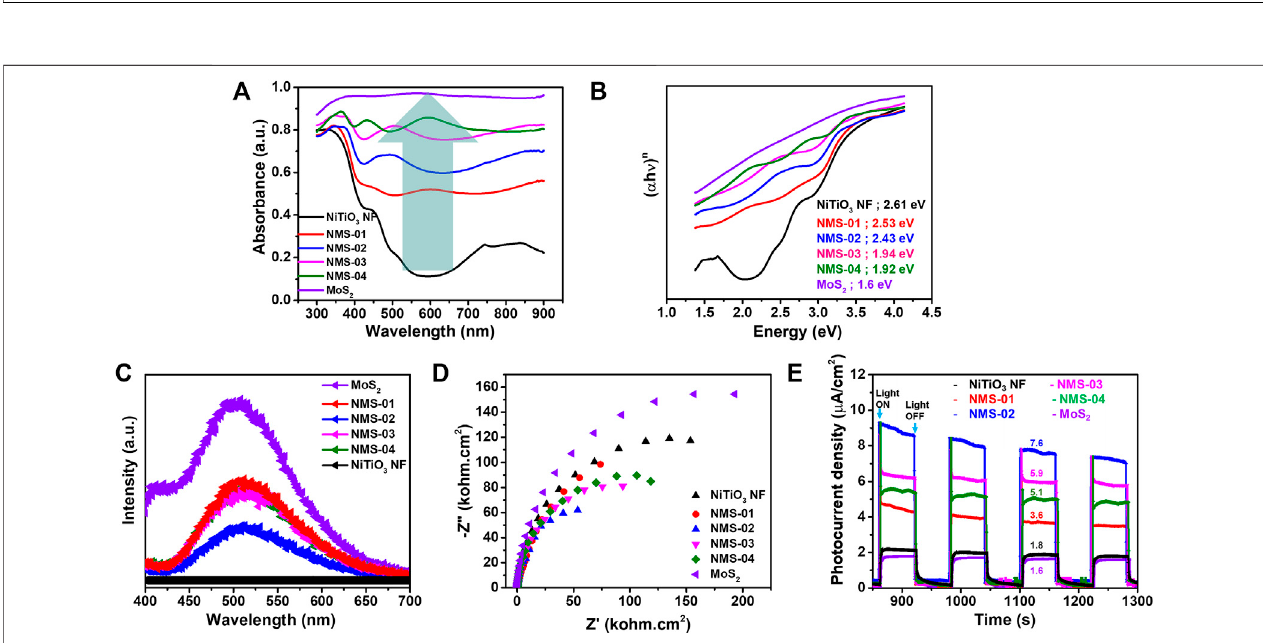
FIGURE5 |(A) Ultraviolet-visible lightabsorption (B) bandgap energy, (C) photoluminescence, and (D) electrochemicalimpedance spectra expressed as Nyquist plots, (E) photocurrent density measurements for the pristine NiTiO 3 nano fi bers and various hybrid structures.